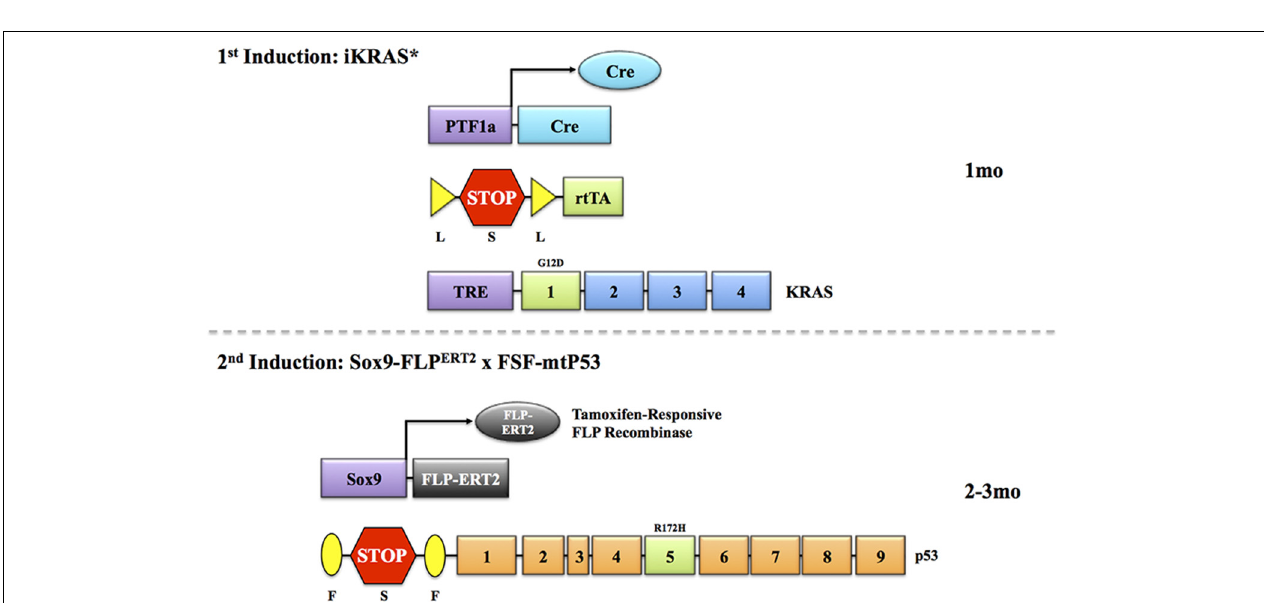
genes are induced simultaneously in the developing embryo. Despite a human-like histotype, these models have yet to be accurate predictors of outcomes observed in clinical trials. Therefore, we propose that using combinations of several systems to drive sequential Kras , p16 , and SMAD4/p53 mutations may lead to more human-like disease that responds to therapy more like that observed in the clinic.